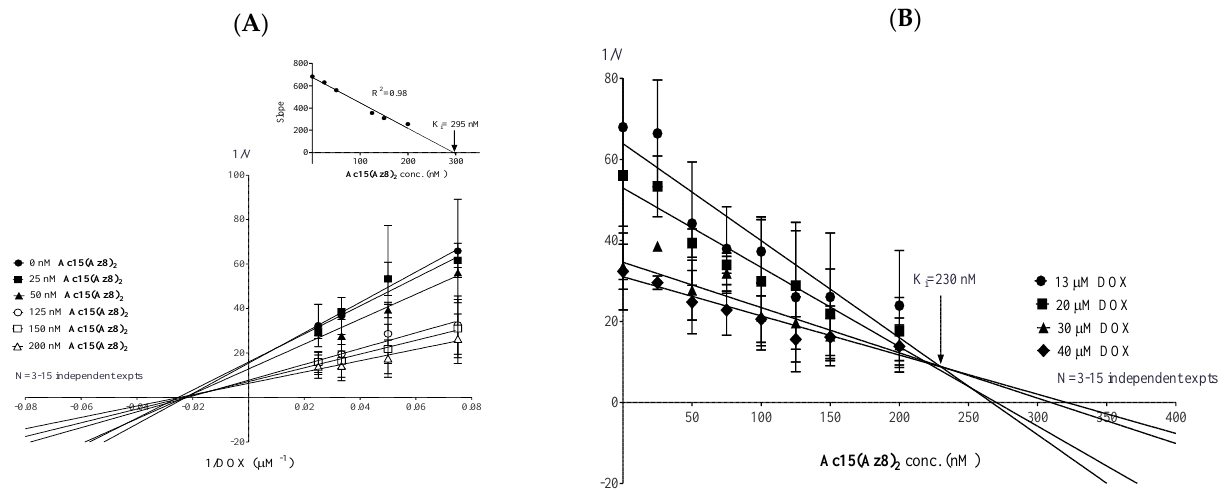
Figure 5. Lineweaver – Burk and Dixon plot for Ac15(Az8) 2 and DOX. S1M180 cells were incubated with different concentrations of Ac15(Az8) 2 and DOX. The cells were pre-treated with Ac15(Az8) 2 for 2 h and then incubated with DOX for 1 h at 37 °C. After incubation, the cells were washed with ice-cold PBS, and the intracellular DOX level was measured. ( A ) In Lineweaver – Burk plot, the reciprocal of DOX retention rate (V, μM/min/500,000 cells) is plotted against reciprocal of DOX concentration used. Six lines of Ac15(Az8) 2 pass through the same intercepts at the x -axis, which is K m for the DOX. The apparent K i value is determined (295 nM) by linear regression analysis from the slope of double reciprocal plots versus the concentration of Ac15(Az8) 2 (inset of Figure 5A). ( B ) In Dixon plot, reciprocal of DOX retention rate (1/V) was plotted against concentration of Ac15(Az8) 2 . Four lines of DOX intercept at a point, which is the K i (230 nM) for the Ac15(Az8) 2 . Each data point is presented as mean ± S.D.